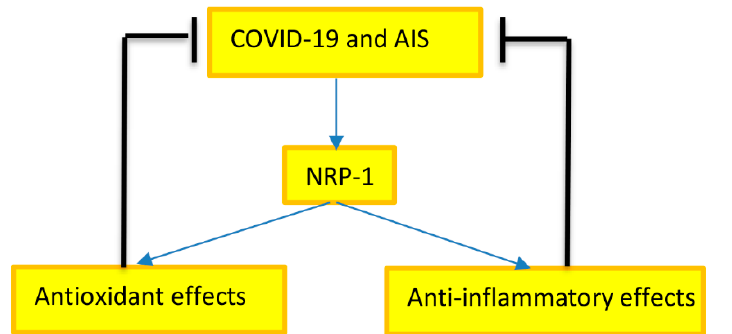
Figure 14. The potential role of neuropilin-1 (NRP-1) in COVID-19 and acute ischemic stroke